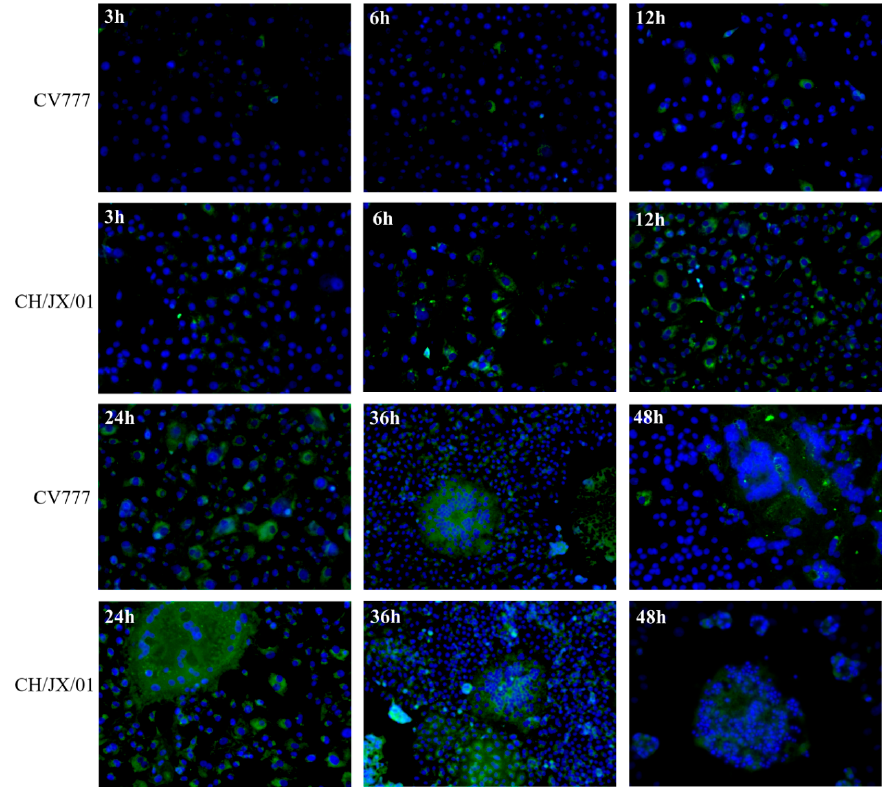
Figure 3. Indirect immunofluorescence assay to detect infection of PEDV strains CV777 and CH / JX / 01 in Vero-81